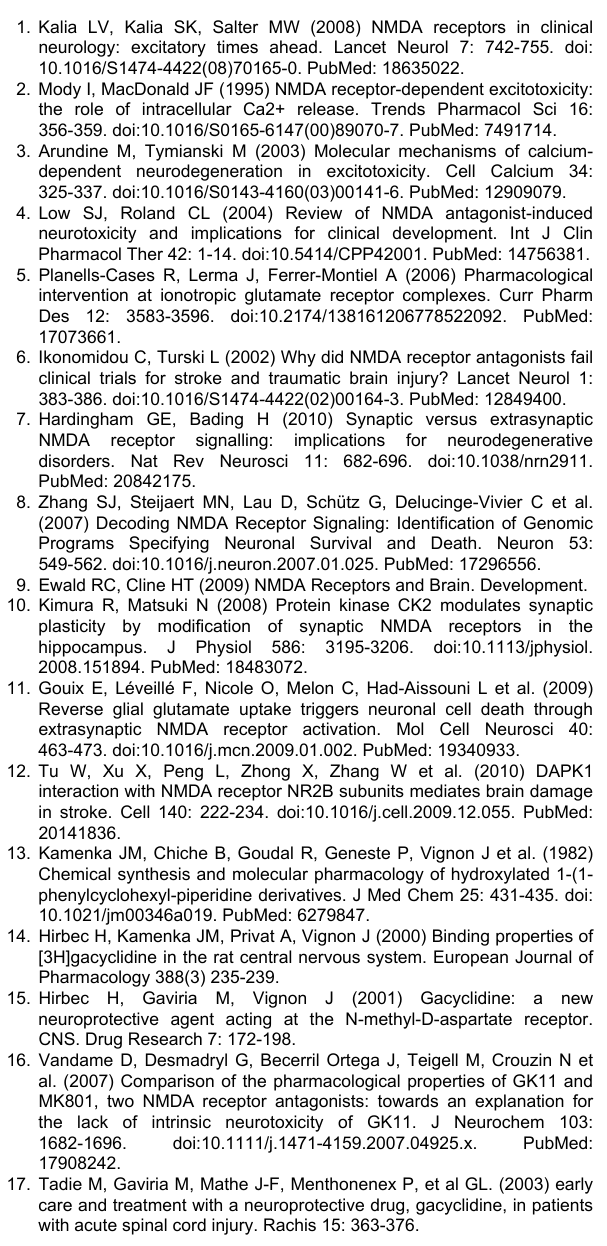
Table S1. List of genes deregulated after MK801 and/or GK11 treatment. NB: Grey-colored lines correspond to genes used in qPCR validation